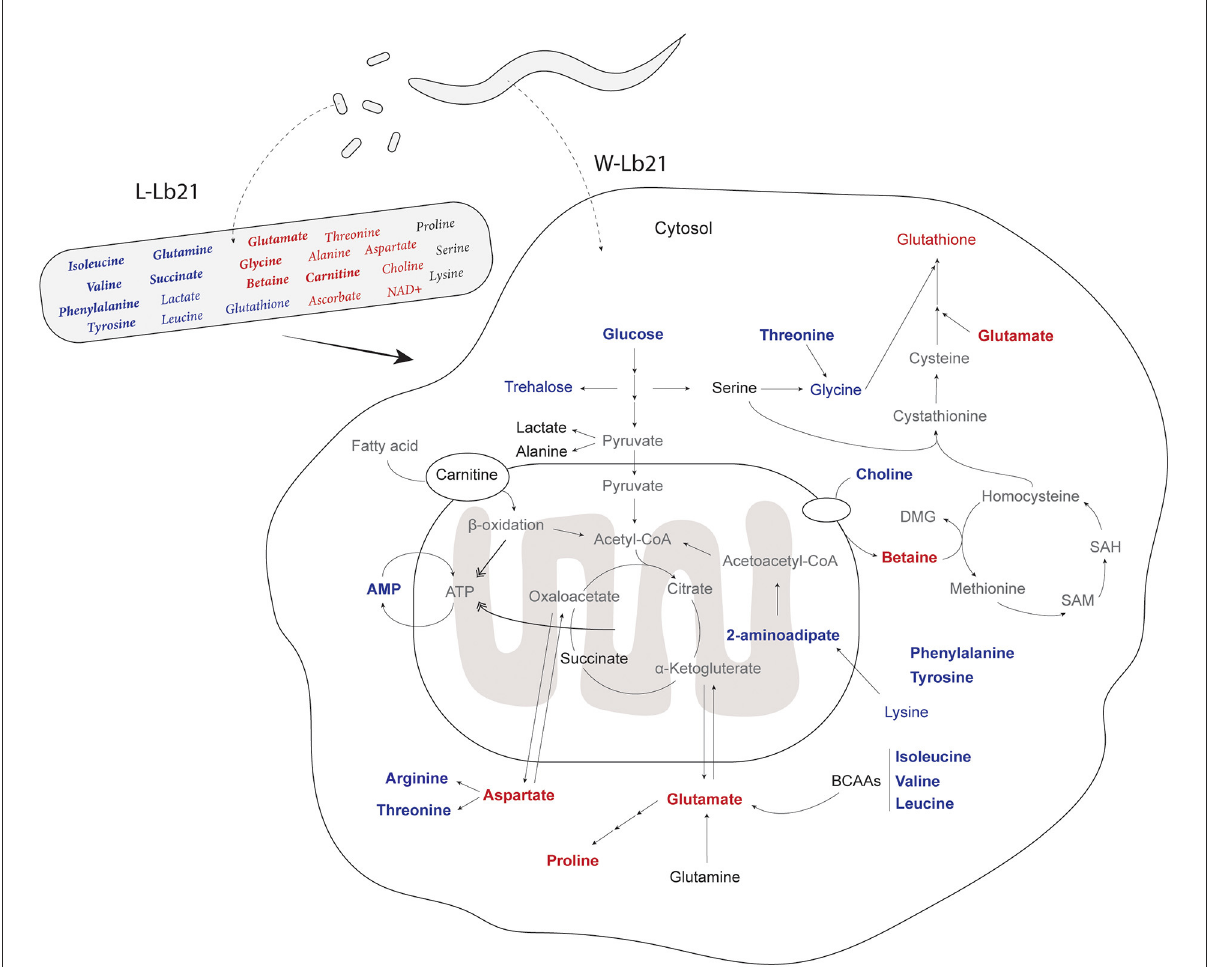
FIGURE4 Metabolic characterization of C. elegans fed Lb21: Metabolites that are significantly differently identified by t -test between L-OP50 and L-Lb21 or W-OP50 and W-LB21 are colored; red are increased, blue are decreased, and those without significant changes in black. Metabolites in bold are one of the 20 metabolites identified by the sPLS-DA analysis. Metabolites in gray were not